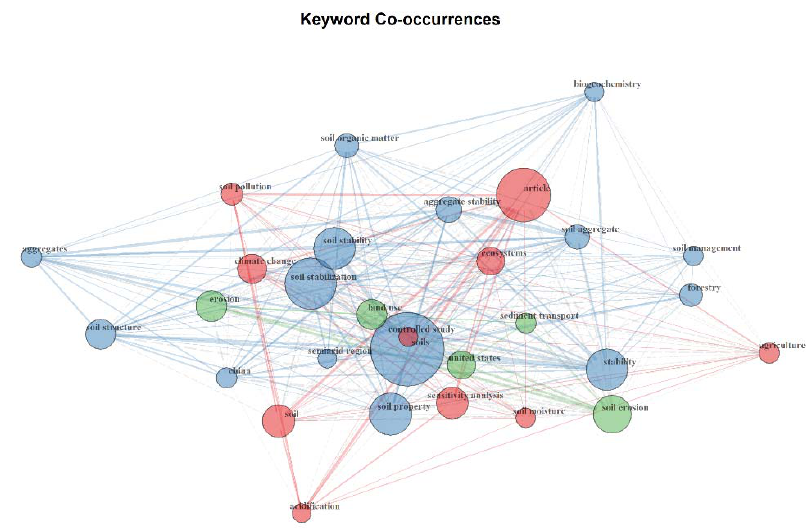
Figure 7. Keyword co-occurrences.